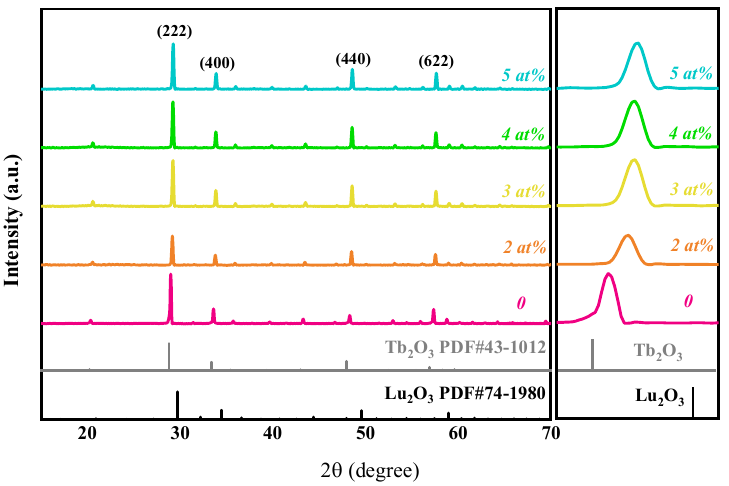
Figure 1. XRD patterns of (Tb 0.7 Lu 0.3 ) 2 O 3 ceramics with 0~5 at% ZrO 2 as sintering aids after hot isostatic pressing sintering.